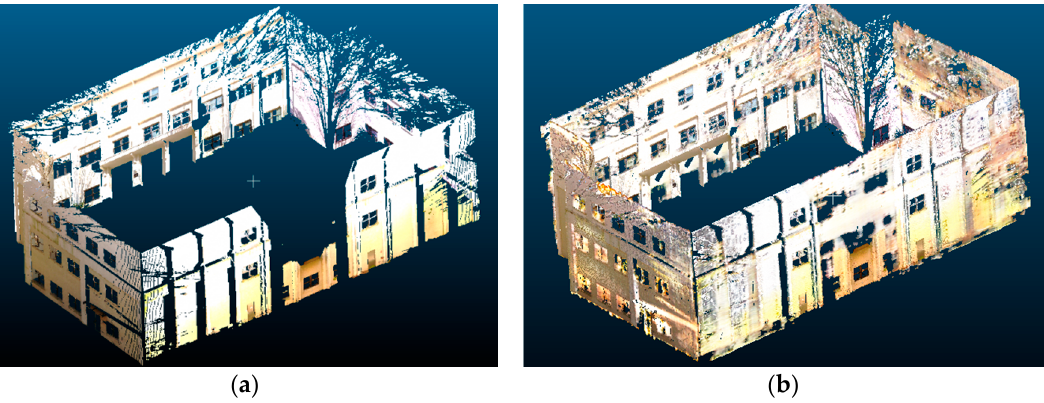
Figure 13. Example of 3D scene completion of a full building from partial scans: ( a ) input point cloud and ( b ) point cloud result after orthographic projection and generative adversarial inpainting.